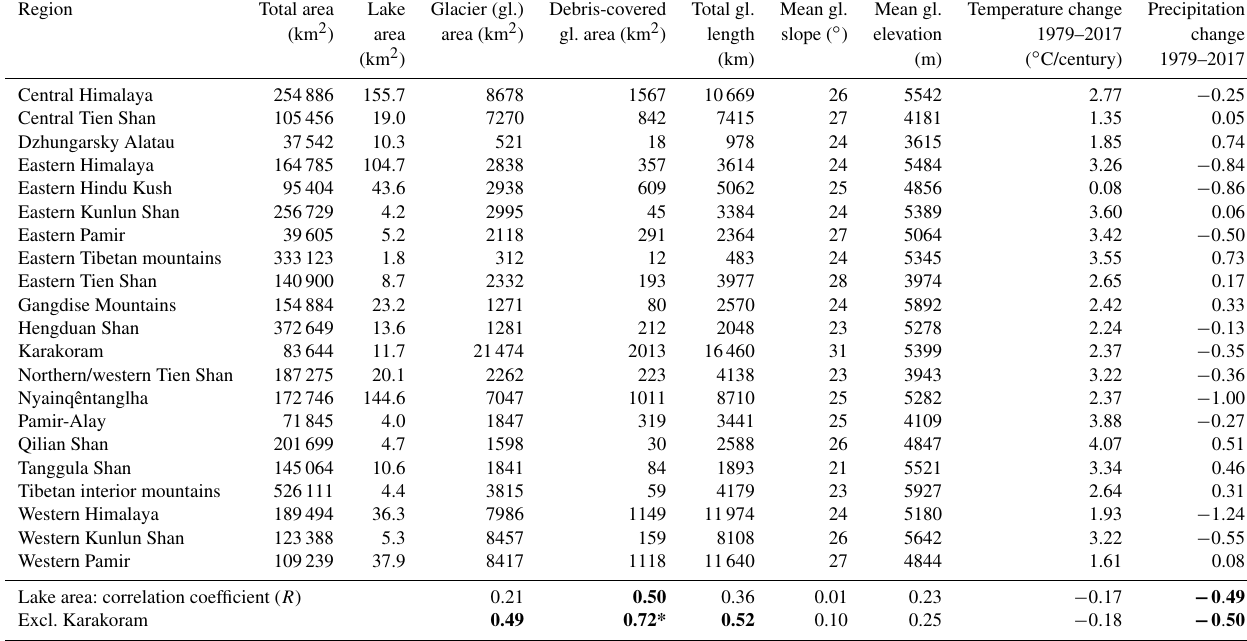
Table A5. Regional summary of key topographic, geomorphic, and climatological parameters compared to proglacial- and supraglacial-lake area in 2017. Correlation coefficients are bold where p < 0 . 05; * indicates p < 0 . 01. Region